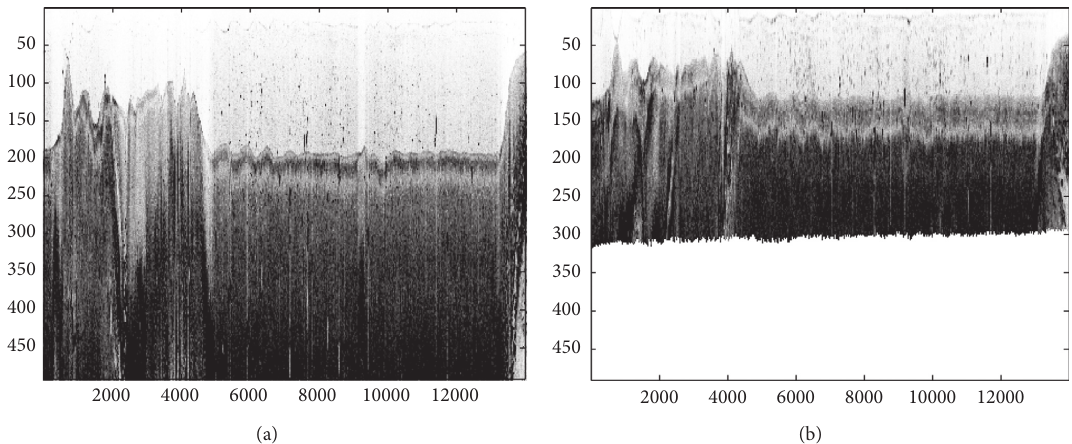
Figure 7: Separate SSS images of the port and starboard sides without blind zone after high-frequency noise and outliers filtering: (a) port side and (b) starboard side.